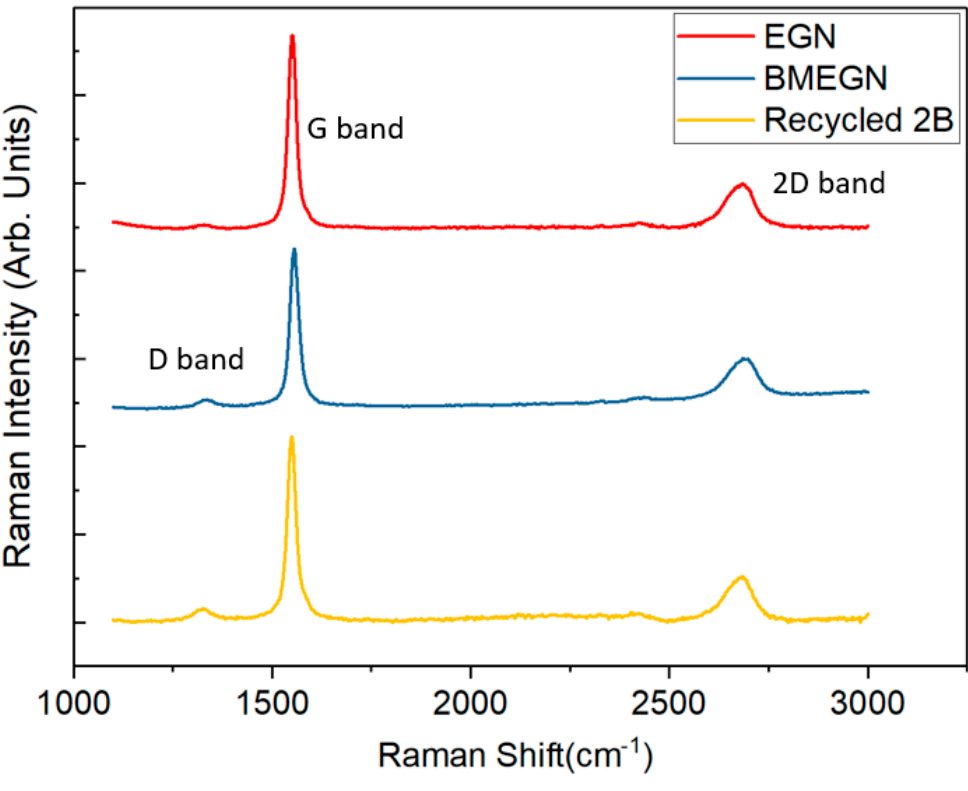
Figure 5. Comparison of Raman spectra (laser excitation 569 nm) for all three types of graphite sample.